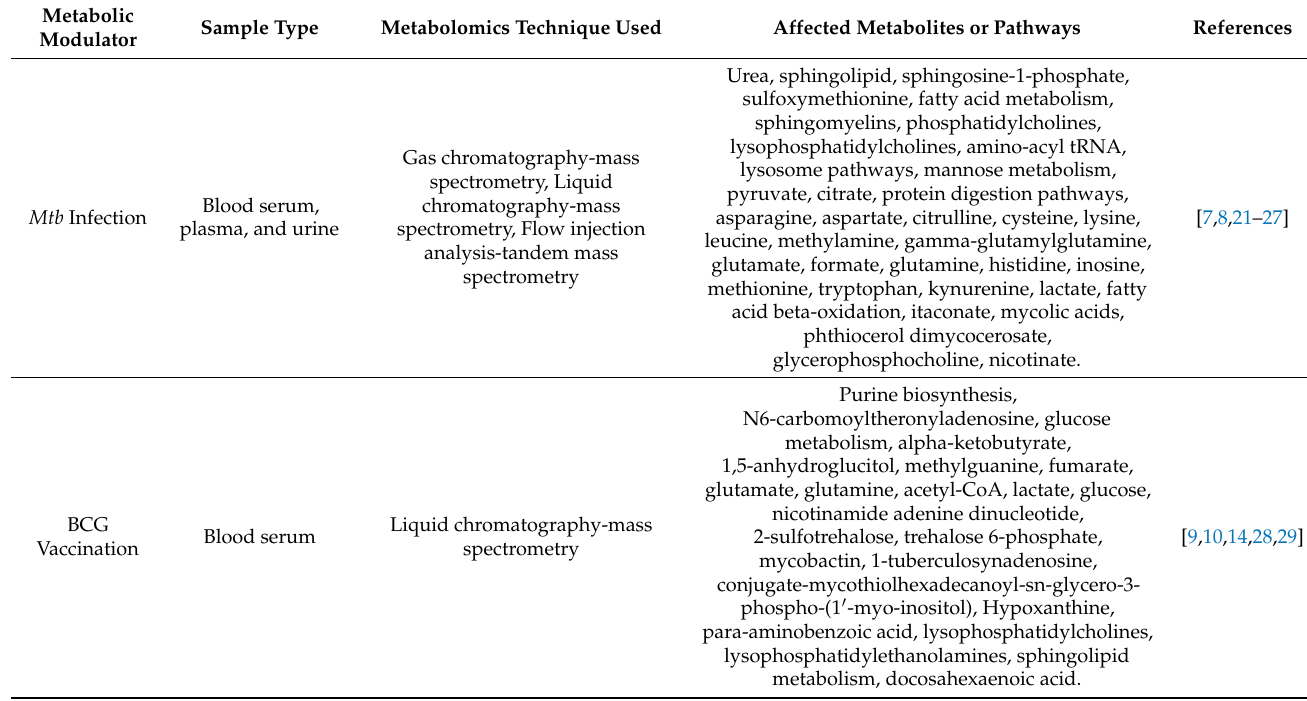
Table 1. Metabolic changes upon Mtb infection and BCG vaccine